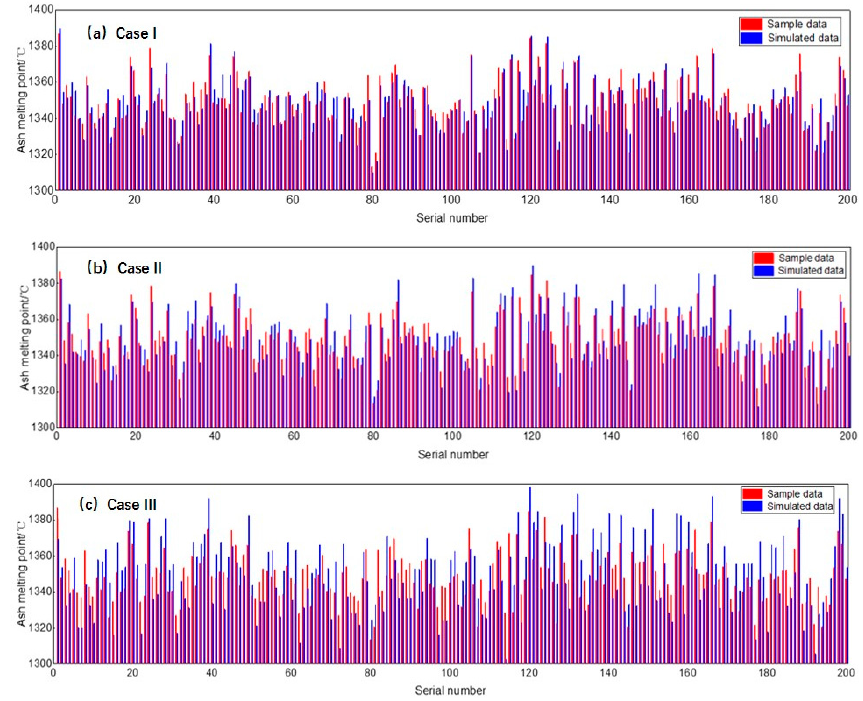
Figure 5. Original and simulated series of AMP in (a) Case I, (b) Case II and (c) Case III.